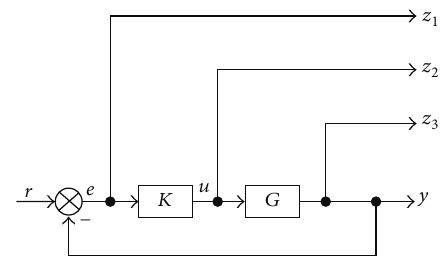
Figure 4: Structural scheme of the designed system.